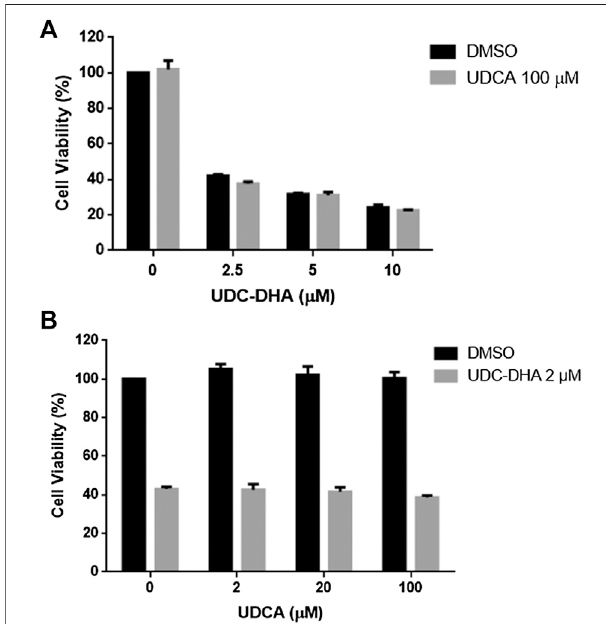
FIGURE 7 | An excess amount of UDCA does not affect growth inhibitory effect of UDC-DHA. (A) HepG2 cells were treated with indicated concentrations of UDC-DHA in the absence or presence of 100 μ M UDCA for 72 h, followed by the MTT assay. (B) HepG2 cells were treated with increasingamountofUDCAintheabsenceorpresenceof2 μ MofUDC-DHA. Dataarepresentedasmean ± SEMofatleastthreeindependentexperiments.